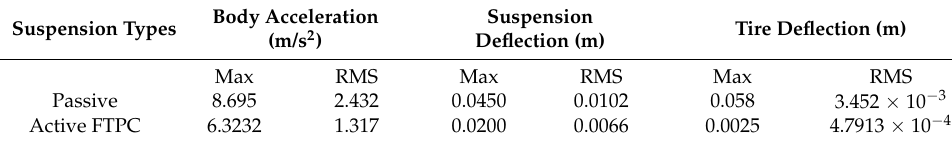
Table 2. RMS comparison of the vehicle’s dynamic responses with sensor